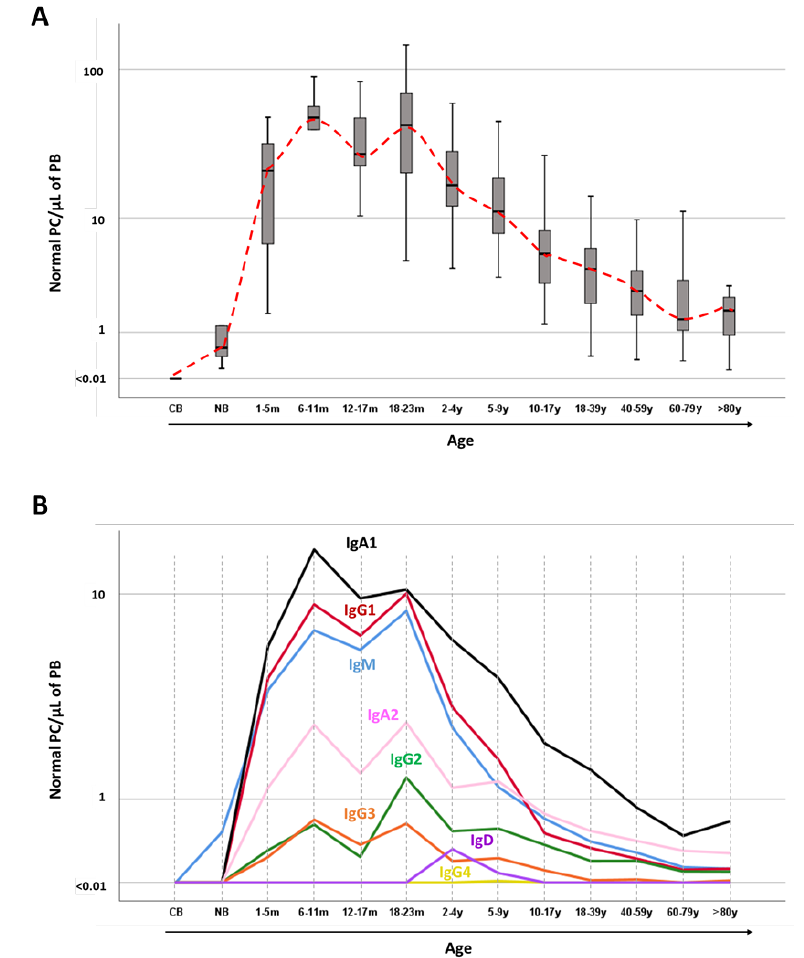
Figure 1. Normal plasma cell kinetics in blood from healthy individuals through life. ( A ) displays the overall distribution of total absolute normal PC counts in cord blood and peripheral blood per age group, while in ( B ) the median absolute counts of PC expressing distinct immunoglobulin isotypes and immunoglobulin subclasses are shown for the same age intervals. CB, cord blood; m, months; NB, newborn; PB, peripheral blood; PC, plasma cells; y, years. Data adapted from Blanco et al. [48]. From the phenotypic point of view, circulating normal PC show a heterogeneous profile reflecting an ongoing (continuous) maturation, with transition from recently produced tissue plasmablasts